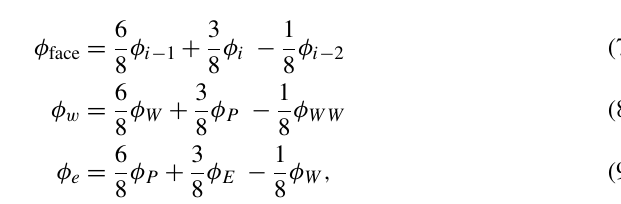
sible sediment/volume water and L and S are the right-hand side differential operator of Eqs. (2) and (3)